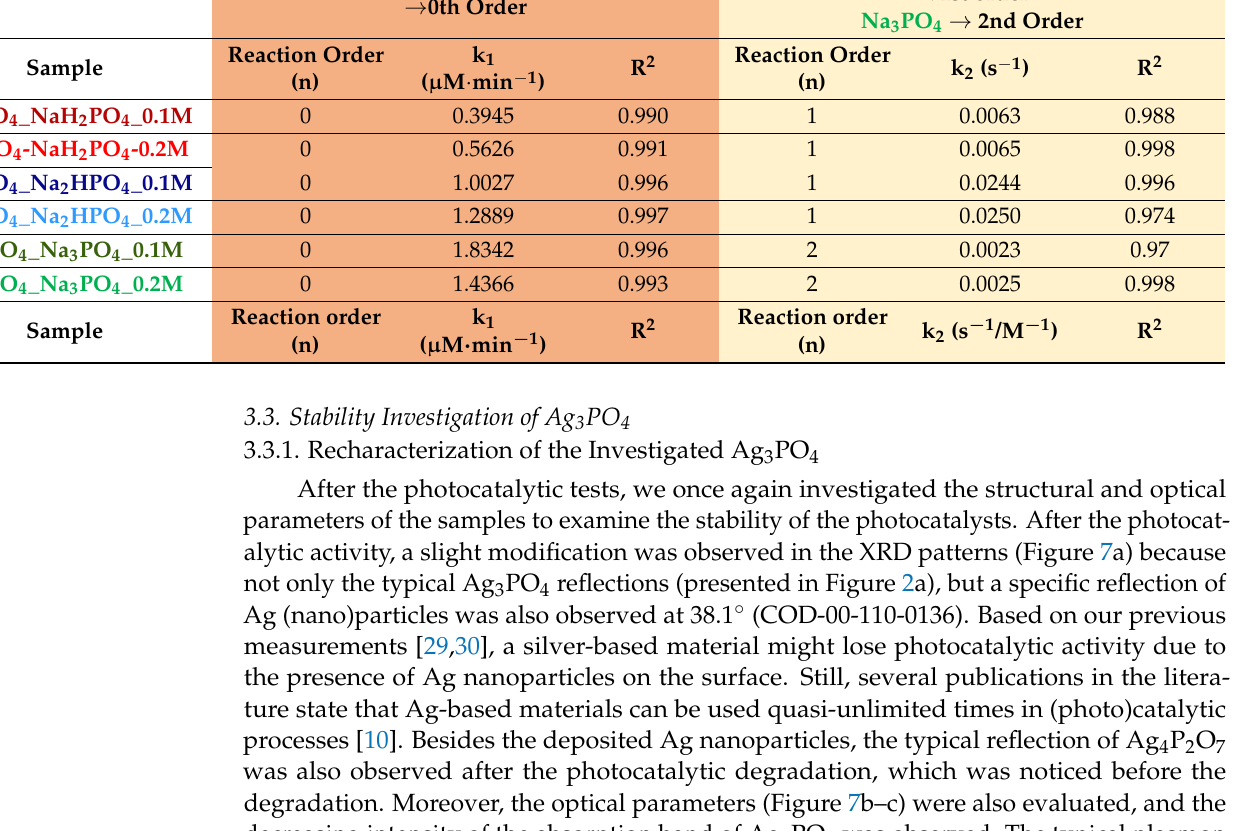
Table 2. Kinetics of methyl orange degradation of the Ag 3 PO 4